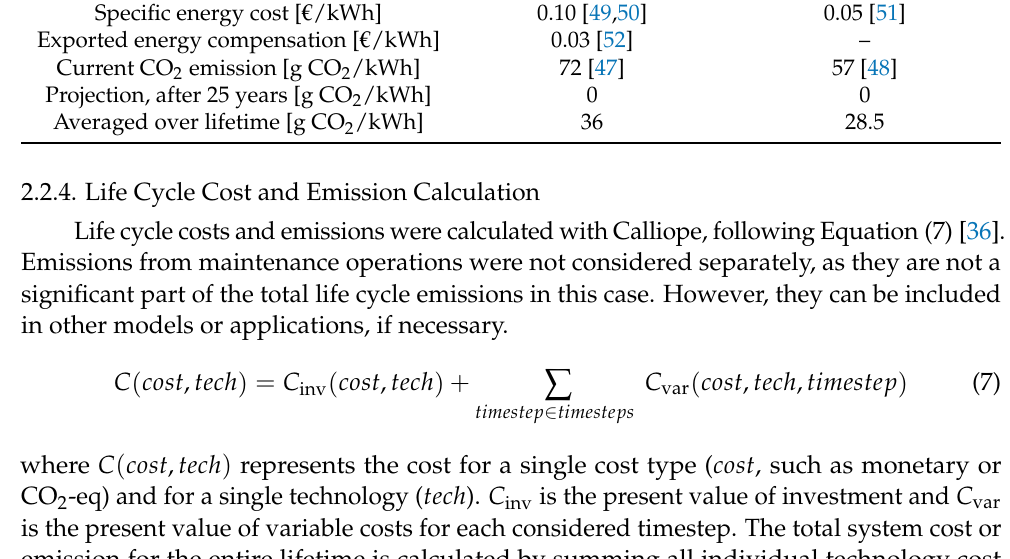
Table 5. Cost and emission parameters for energy grid connections.